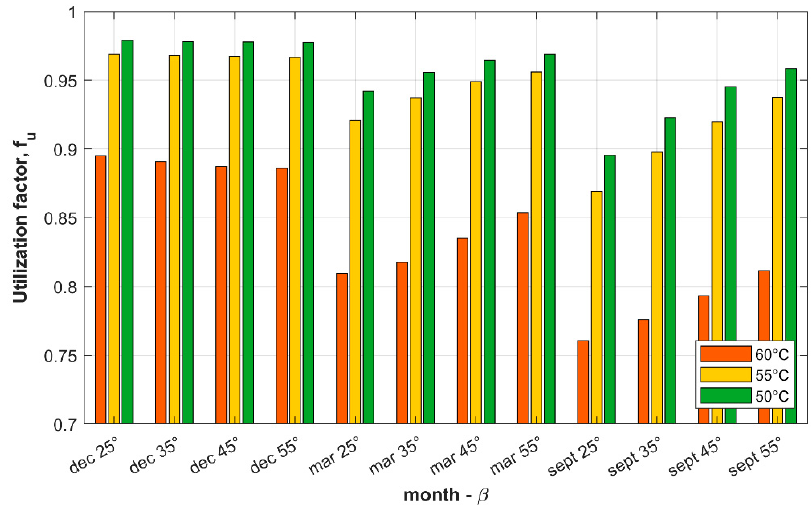
Figure 5. MED utilization factor.